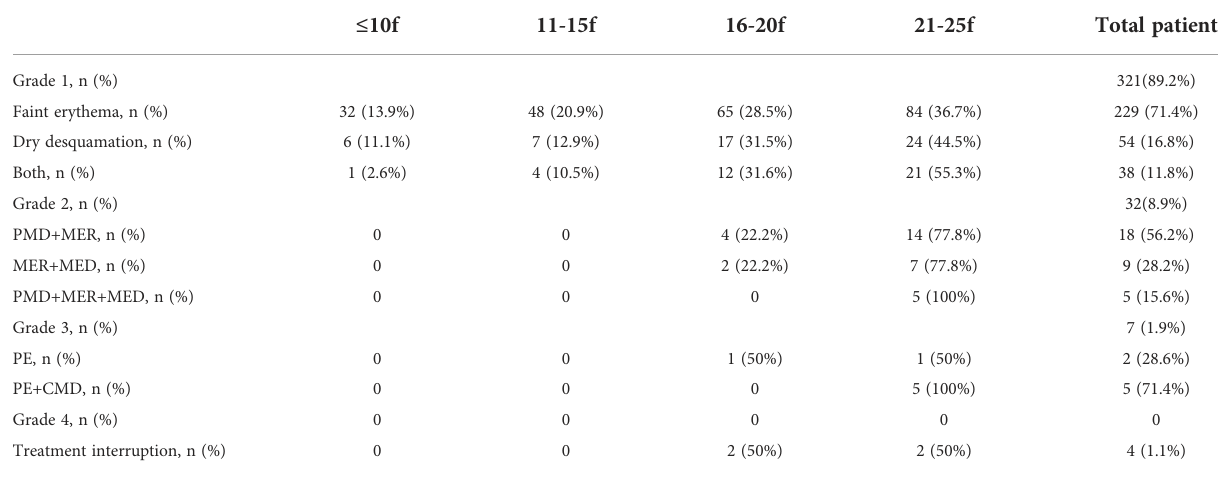
TABLE 4 Skin toxicity during radiotherapy.